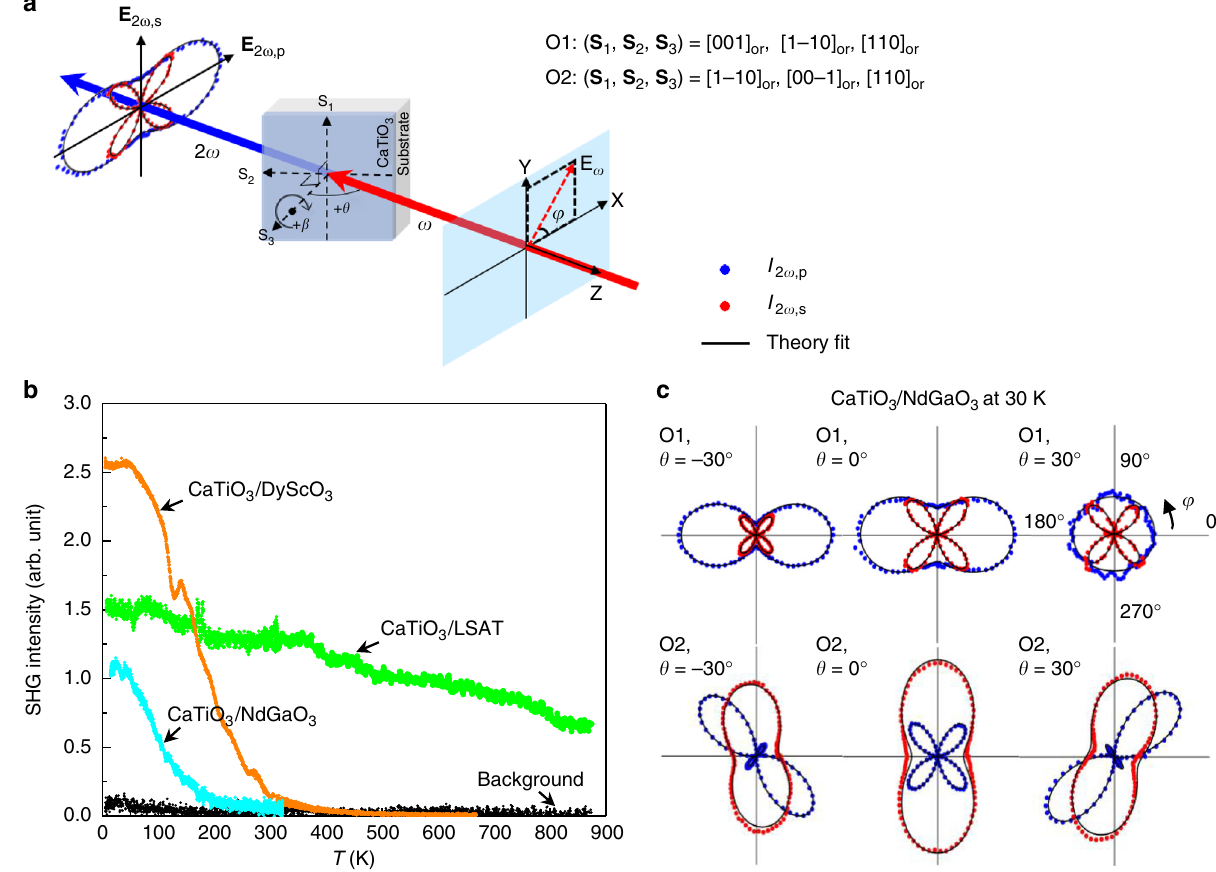
Fig. 5 SHG measurements on ultrathin CaTiO 3 fi lms. a Schematic of far- fi eld transmission optical second harmonic generation (SHG) setup. Linear polarized fundamental λ = 800nm, with polarization direction described by φ is incident onto the sample at an angle θ . Transmitted s-/p-polarized SHG signal E 2 ω ,s , E 2 ω ,p at λ = 400 nm is measured. b Temperature dependent SHG signal of CaTiO 3 on NdGaO 3 , DyScO 3 , and LSAT reveals Curie temperature T I I C of 200, 350, and >900 K, respectively. c Polarimetry signal 2 ω ,s (red dots), 2 ω ,p (blue dots) on CaTiO 3 /NdGaO 3 at 30 K are shown. Two sample orientations, O1 and O2, are experimentally measured as described by ( S 1 , S 2 , S 3 ) under orthorhombic notation. Theory fi ts (black lines) reveals a single domain m symmetry of the CaTiO 3 on NdGaO 3 at 30 Scanning transmission electron microscopy imaging . The scanning transmis- sion electron (STEM) images of CaTiO 3 thin fi lms on NdGaO 3 , DyScO 3 , and LSAT under (100) pc , (010) pc , and (110) pc zone axes were collected on an FEI Titan G2 double aberration-corrected HR-STEM at 300kV with a probe illumination angle of 28 mrad. High-angle annular dark- fi eld (HAADF) and annular bright fi eld (ABF)-like images were obtained with collection angles of 42 – 244 and 9 – 51 mrad, respectively. At each sample location, images were taken with the STEM fast scan direction set to 0° and 90° with respect to the substrate interface direction. These image pairs were then drift corrected, after which the images were superimposed. Analysis of the STEM images was performed using custom-written MATLAB code. The sub-pixel resolution of the cations and oxygen positions were determined by fi tting a seven parameter 2D elliptical Gaussian pro fi le (to account for any ellipticity in the intensity distribution) to the HAADF/ABF intensity distribution. Optical second harmonic generation measurements . Optical second harmonic generation (SHG) polarimetry and temperature dependent measurements were performed in a far- fi eld transmission setup using femtosecond pulses at λ = 800 nm generated by a Spectra-Physics Empower Q-switched Nd:YLF pumped Solstice Ace Ti:Sapphire laser system (100fs, 1kHz). The experimental schematic is shown in Fig. 5a, where a linear polarized fundamental fi eld with polarization direction φ incident on the sample at an incident angle θ .The p-polarized ( I 2 ω ,p ) and s- polarized ( I 2 ω ,s ) components of second harmonic fi eld ( E 2 ω ) was fi rst spectrally fi ltered and then detected by a photo-multiplier tube, using lock-in method (SR830). For each sample, systematic polarimetry was performed by rotating the incident polarization φ at fi xed θ for two different sample orientations (O1 and O2). SHG polarimetry on CaTiO 3 /NdGaO 3 at 30K was performed at incident angles θ = − 30°, 0°, 30° for two sample orientations, O1: ( S 1 , S 2 , S 3 ) = ([001] or , [1 – 10] or , [110] or ), O2: ( S 1 , S 2 , S 3 ) = ([1 – 10] or , [00 – 1] or , [110] or ), as shown in Fig. 5c (red and blue dots). Similar SHG behavior are also observed in CaTiO 3 /